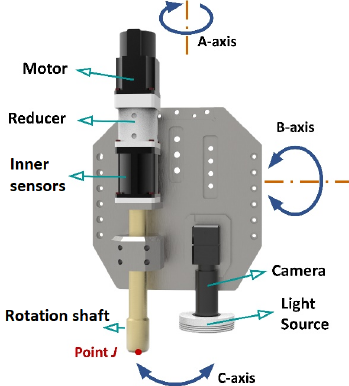
Figure 4. Structure of the robotic end effector.